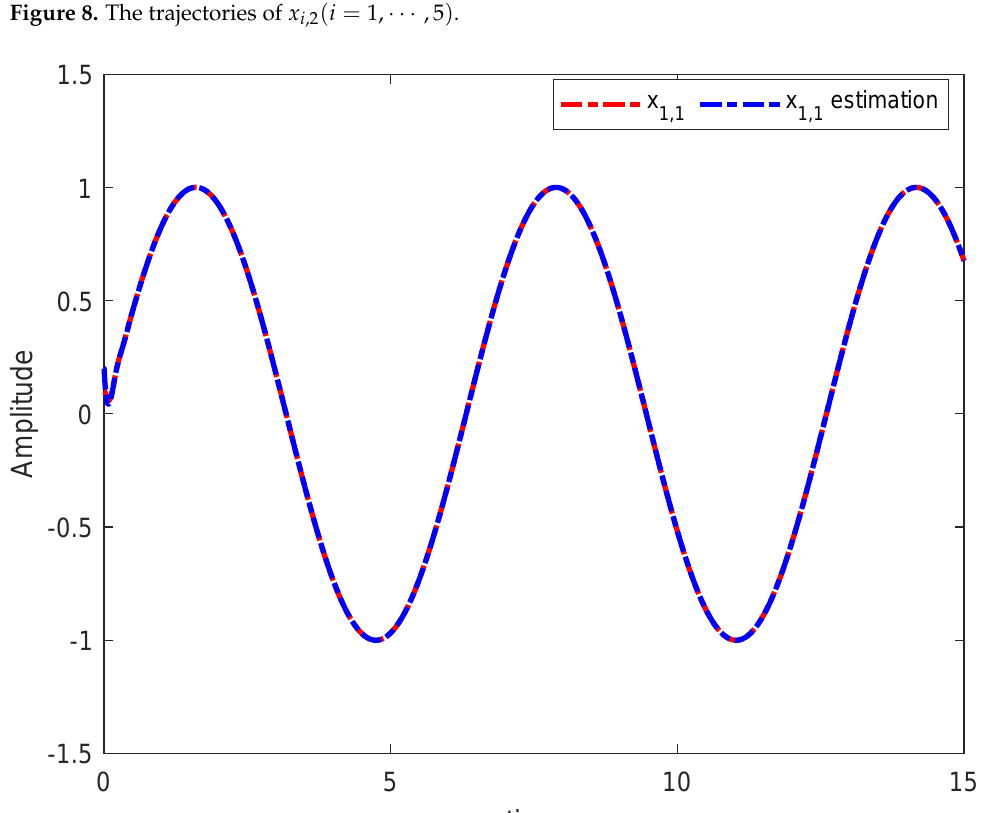
Figure 8. The trajectories of x i ,2 ( i = 1, · · · ,5 ) .